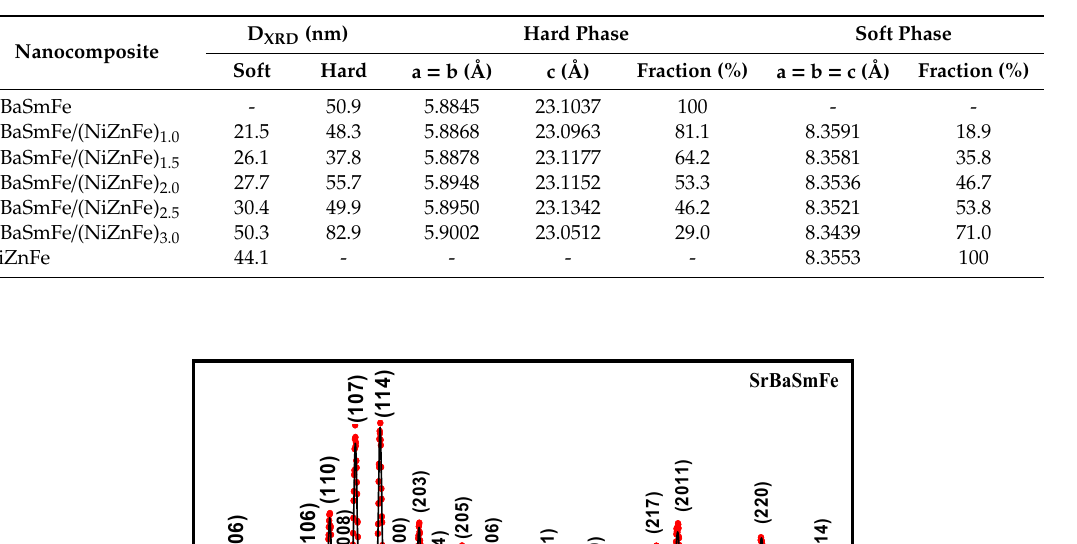
Table 1. Crystallites size (D XRD ), lattice parameters, and phase fractions calculated for both hard (107 plane) and soft (311 plane) phases in hard / soft ferrite nanocomposites of SrBaSmFe / (NiZnFe) x (0 ≤ x ≤ 3).